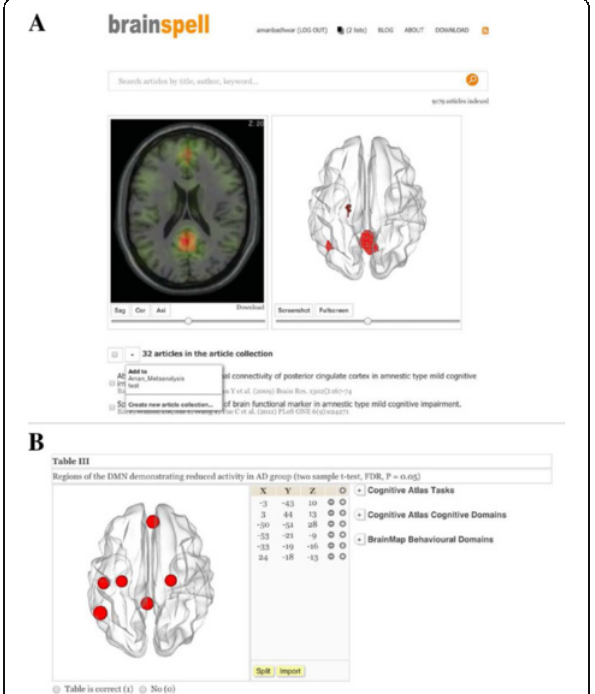
Fig. 1 (abstract A1). 3D volume and mesh showing the aggregated locations of a user/peer-defined collection (Aman_Metaanalysis) containing 32 articles. This user has a total of two collections (or 2 lists), as indicated on the header row. The second collection is named ‘ test ’ . b Highlighted in yellow are the Split and Import links associated with each table in Brainspell. Note: With the exception of the Download link, peer-login is required to access all mentioned Brainspell